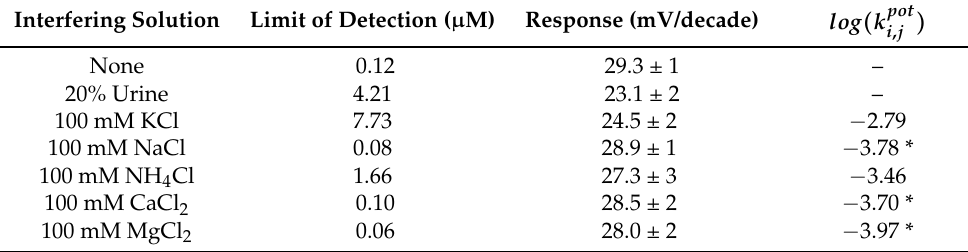
Table 1. The interference of ionic compounds on SUX detection using CX4-conventional ISEs. Interfering Solution Limit of Detection ( µ M) Response (mV/decade) log ( k pot